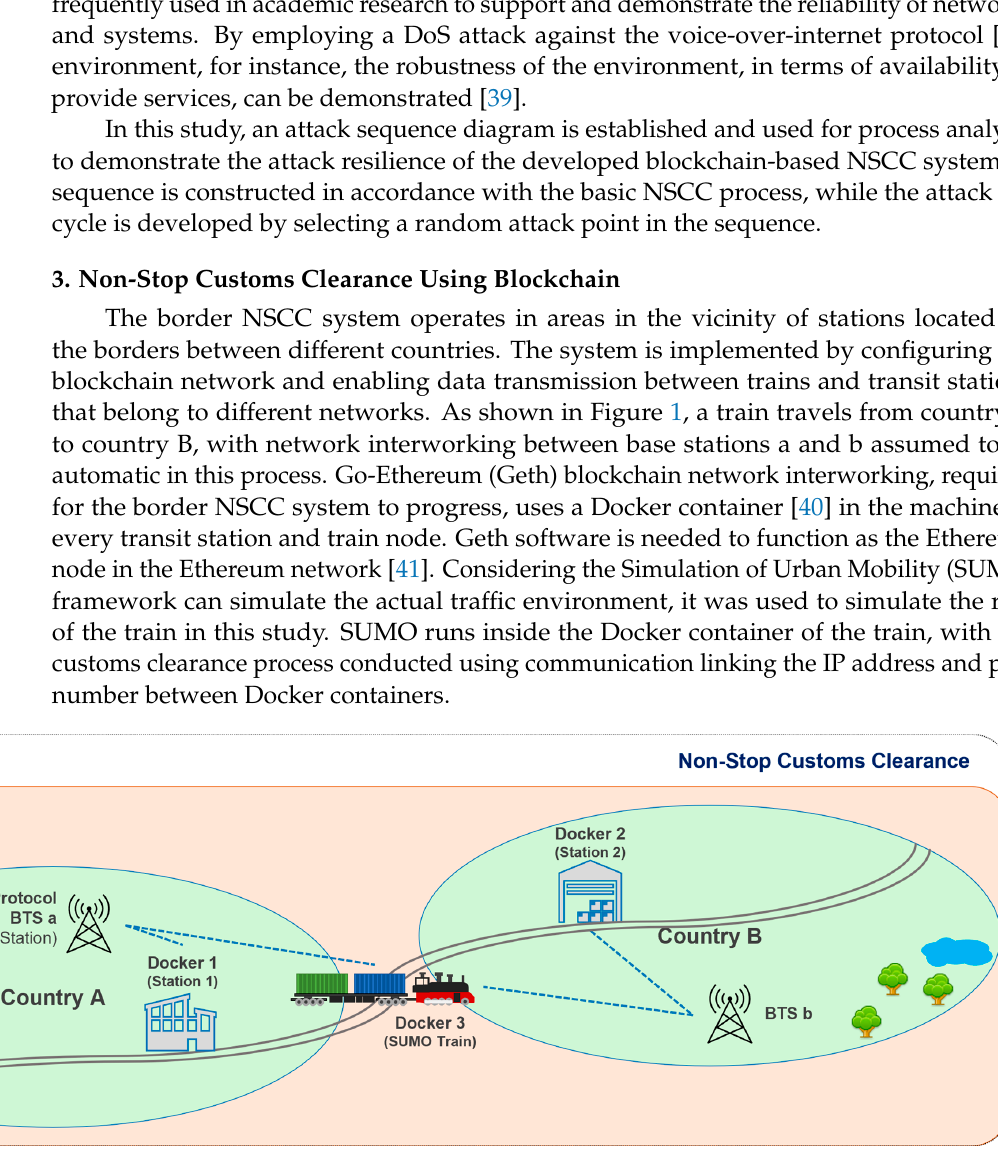
Figure 1. Railway border non-stop custom clearance in real-world simulation.